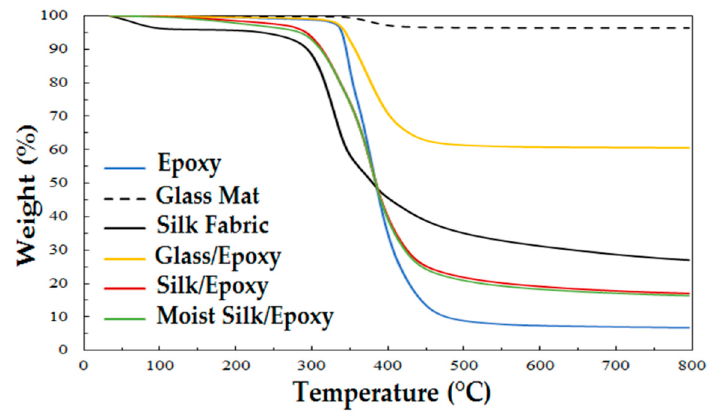
Figure 5. TGA thermographs of neat epoxy, glass mats, silk fabric, as well as glass/epoxy and silk/epoxy laminates, under a nitrogen atmosphere at a heating rate of 10 °C/min.